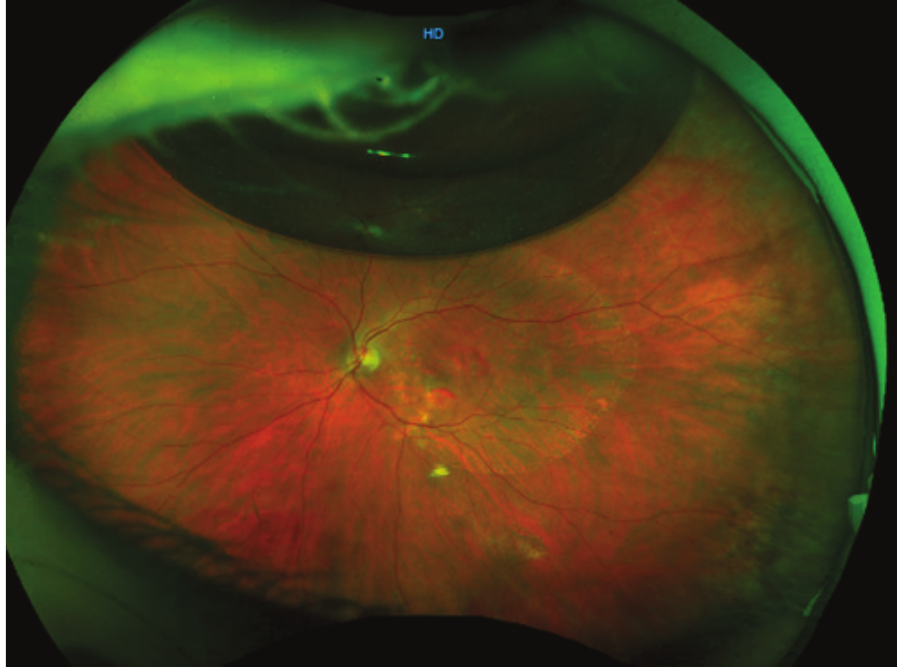
Figure 2. Color fundus photo taken at postoperative week two, demonstrating resolving submacular hemorrhage but new retinal pigment epithelium atrophy extending beyond the area of prior hemorrhage. A C